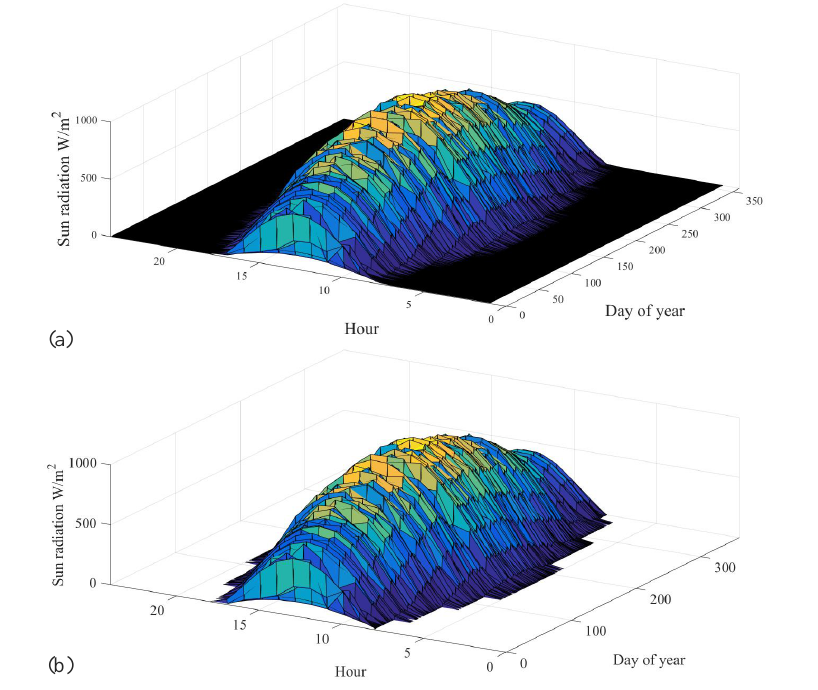
Figure 9. The data cleaning process ( a ) the data before eliminating night hours ( b ) the data after eliminating night